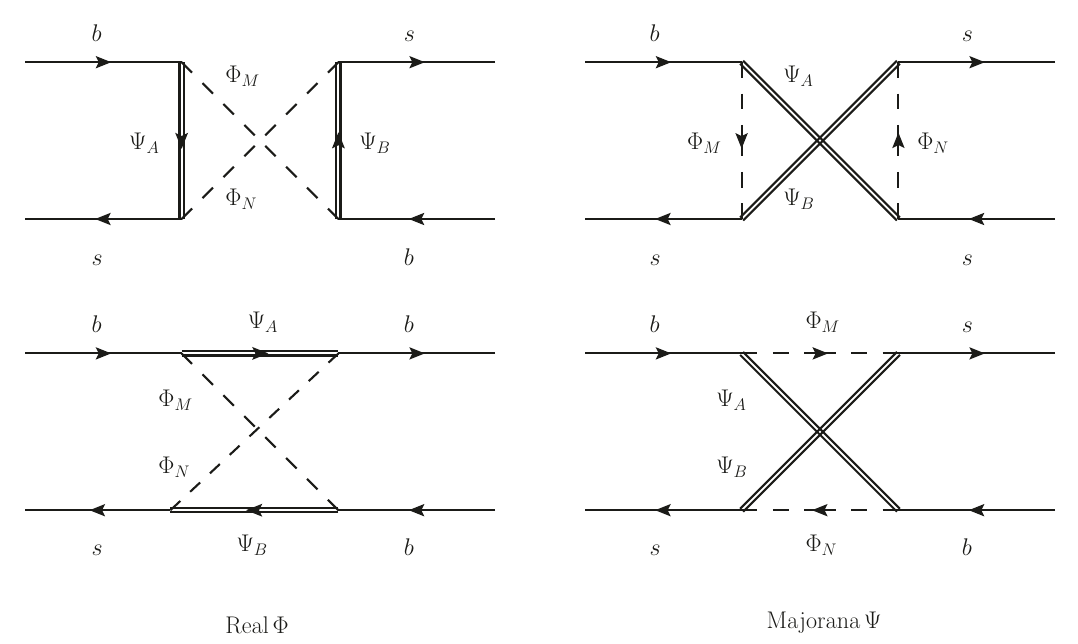
Figure 8 . Box diagrams contributing to B s (cid:0) (cid:22) B s mixing. The diagram on the left is relative to models with real scalars, while the one on the right refers to models with Majorana